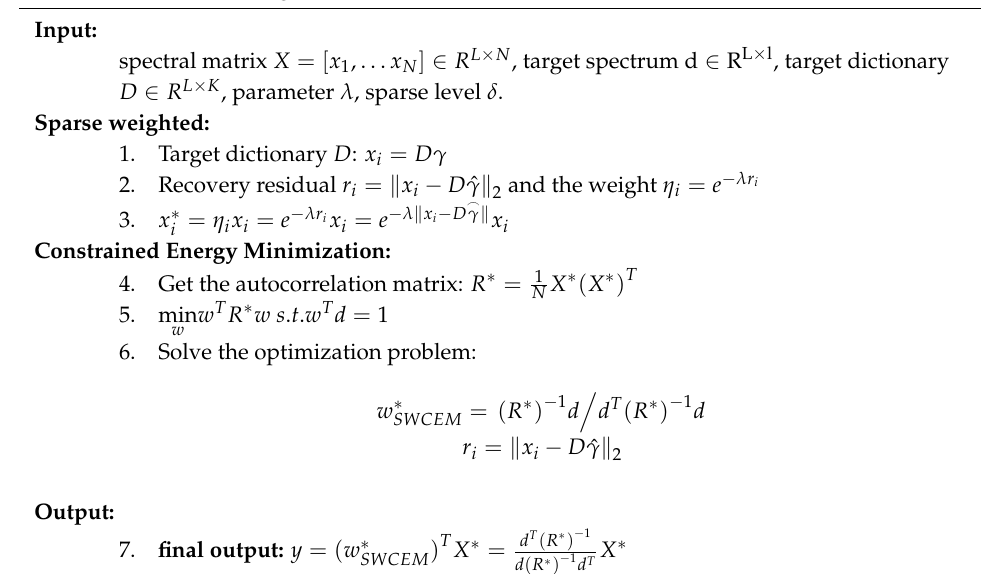
Algorithm 1 SWCEM